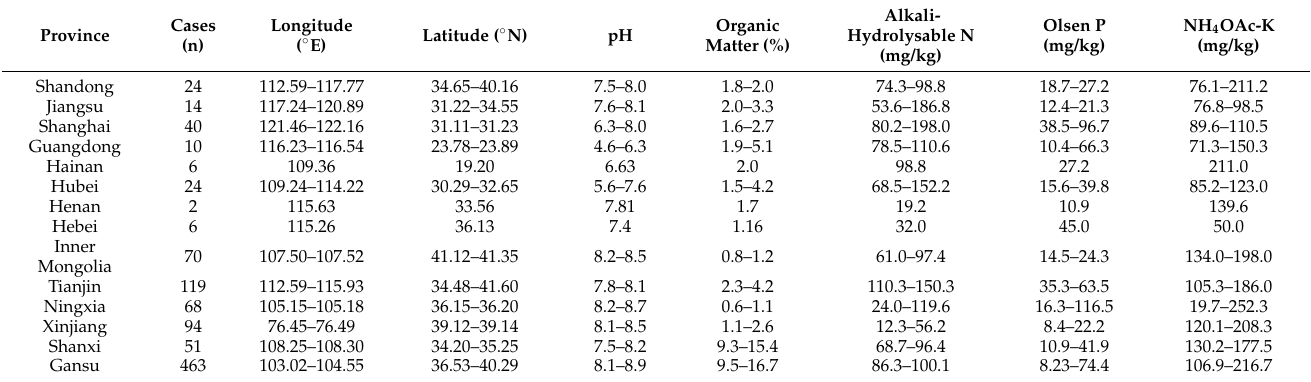
Table 1. Soil characteristics in main melon-producing regions of